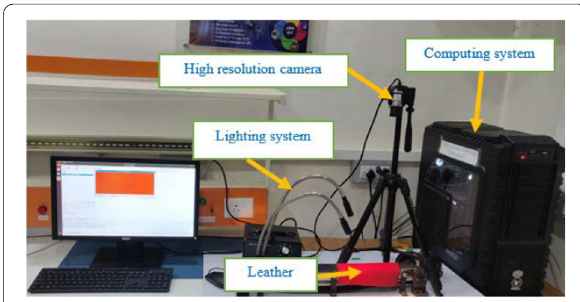
Fig. 1 Machine vision inspection system for defect identification in leather samples